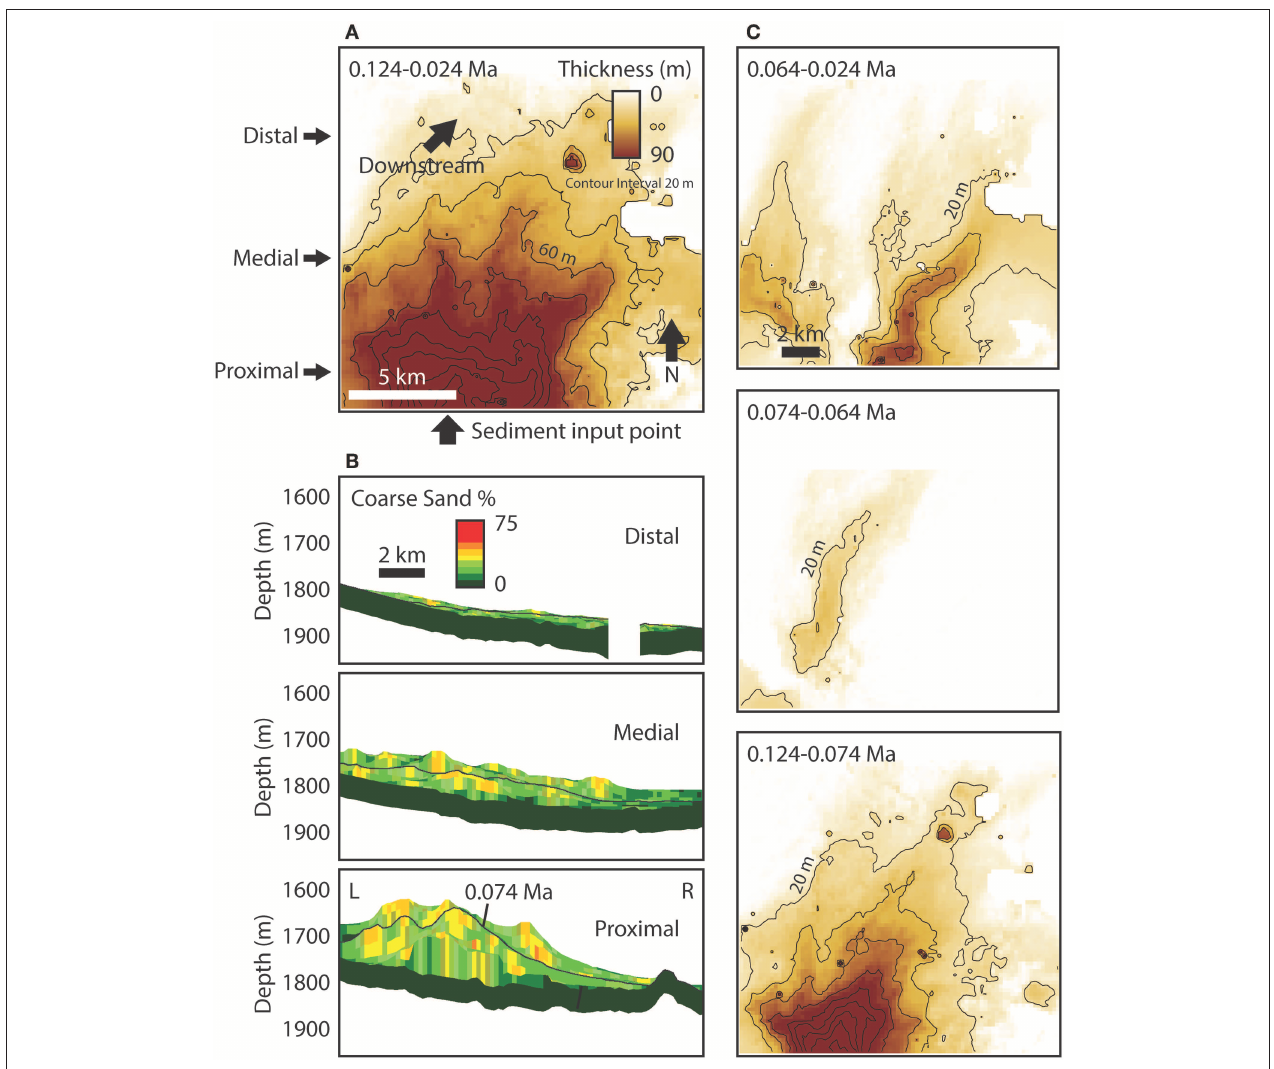
FIGURE 1 | Reference-case model (10 kyr time step) modified from Hawie et al. (2018). (A) Isochore map of the entire model. (B) Cross sections of the model. Left (L) and right (R) orientations in cross sections are left and right in map in part (A) . Cross-section locations are indicated in part (A) . (C) Isochore maps of depositional sequences within the model showing major phases of sediment